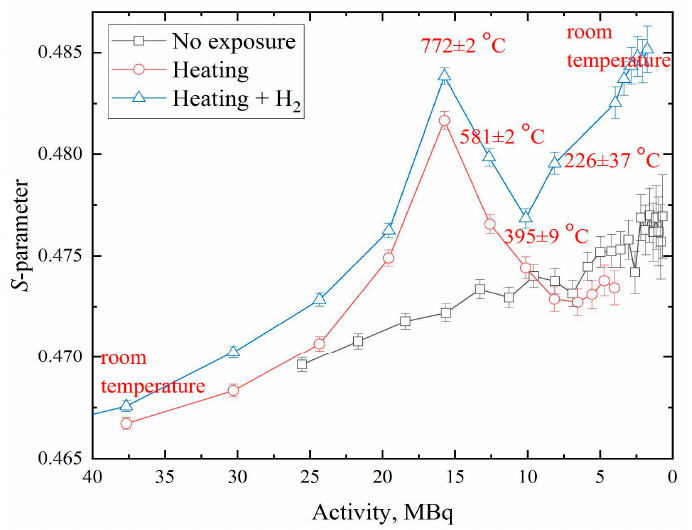
Figure 11. Dependence of S -parameter on activity of 64 Cu source for Ti samples with no exposure, during heating, and hydrogen loading.